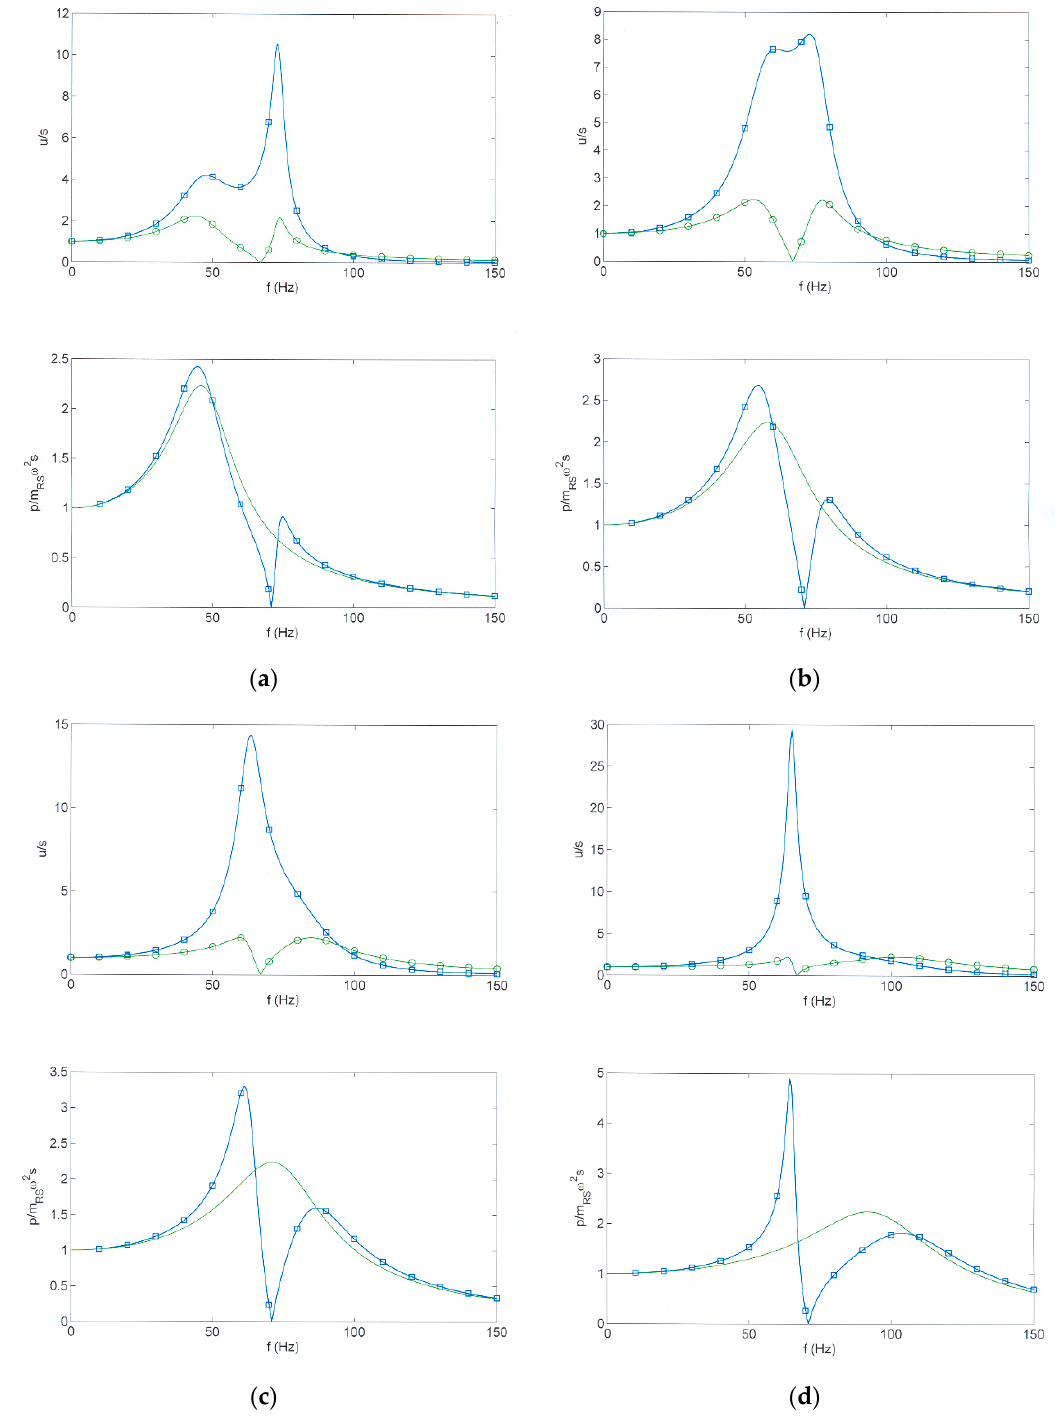
Figure 1. ( a ) Measurement points of the railway vehicle (passenger car) for the test runs, axle boxes A1, A2, bogie B1 and B2, carriage C1 and C2, right hand side, A3, A4, B3, B4, C3, C4 symmetrically on the left hand side; ( b ) one-third octave band spectra of the accelerations of the railway vehicle running with v T = 160 km/h, , wheelset A1 and A2, , vertical bogie part B1 and B2, horizontal bogie part B1, , car body part C1 and C2; ( c ) particle velocities of the track , left and right rail, , sleeper 1 and 2, , sleeper horizontal, sub soil at 2.5 m distance.